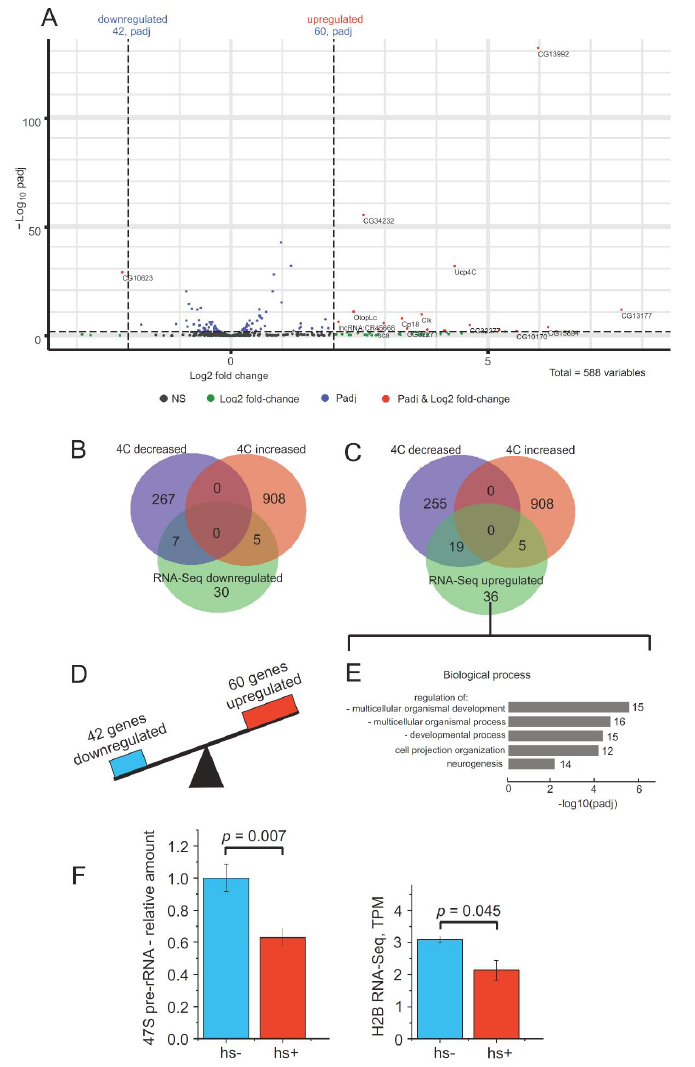
Figure 6. Differential expression of rDNA-contacting genes and rDNA units after heat shock treatment. ( A ) The volcano plot presents the statistically significant log2-fold changes in the expression of rDNA-contacting genes determined in RNA-Seq experiments after heat shock treatment. The expression of 588 rDNA-contacting genes was analyzed. Of these, 42 genes were downregulated while 60 were upregulated. The list of the corresponding rDNA-contacting genes ranked by padj is shown in Table S10. ( B ) The Venn diagram shows the intersections of downregulated rDNA-contacting genes with the lists of genes that revealed a decrease (274 genes) or increase (913 genes) in rDNA contacts as shown in Figure 4A. The list of the corresponding genes is shown in Table S11. GO associations of 42 genes indicated in the Venn diagram are shown in Table S12. ( C ) The Venn diagram shows the intersections of upregulated rDNA-contacting genes with the lists of genes that revealed a decrease (274 genes) or increase (913 genes) in rDNA contacts as shown in Figure 4A. The list of corresponding genes is shown in Table S13. ( D ) A scheme illustrating that heat shock treatment induces changes in the contacts with nucleoli of about 100 genes coupled with the downregulation or upregulation of these genes. ( E ) The top five GO terms associated with 60 upregulated rDNA-contacting genes and the regulation of development. The values to the right of the bars indicate the number of corresponding genes. The list of these genes is shown in Table S14. ( F ) Expression of rDNA and the histone H2B gene (CG33868) in S2 cells before and after heat shock treatment. qRT-PCR experiments showing the relative expression of pre-rRNA and RNA-Seq data for H2B gene expression are